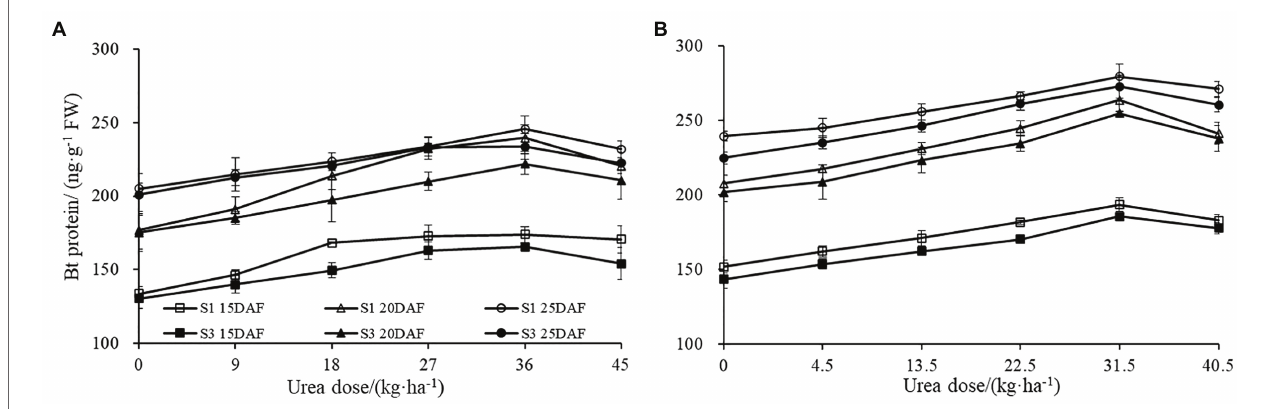
FIGURE 1 | The boll shell Bt protein content under different urea doses in 2017 (A) and 2018 (B) . FW represents the fresh weight of the sample, DAF represents the abbreviation of “days after flowering,” and S1 and S3 represent the Sikang 1 and Sikang 3,